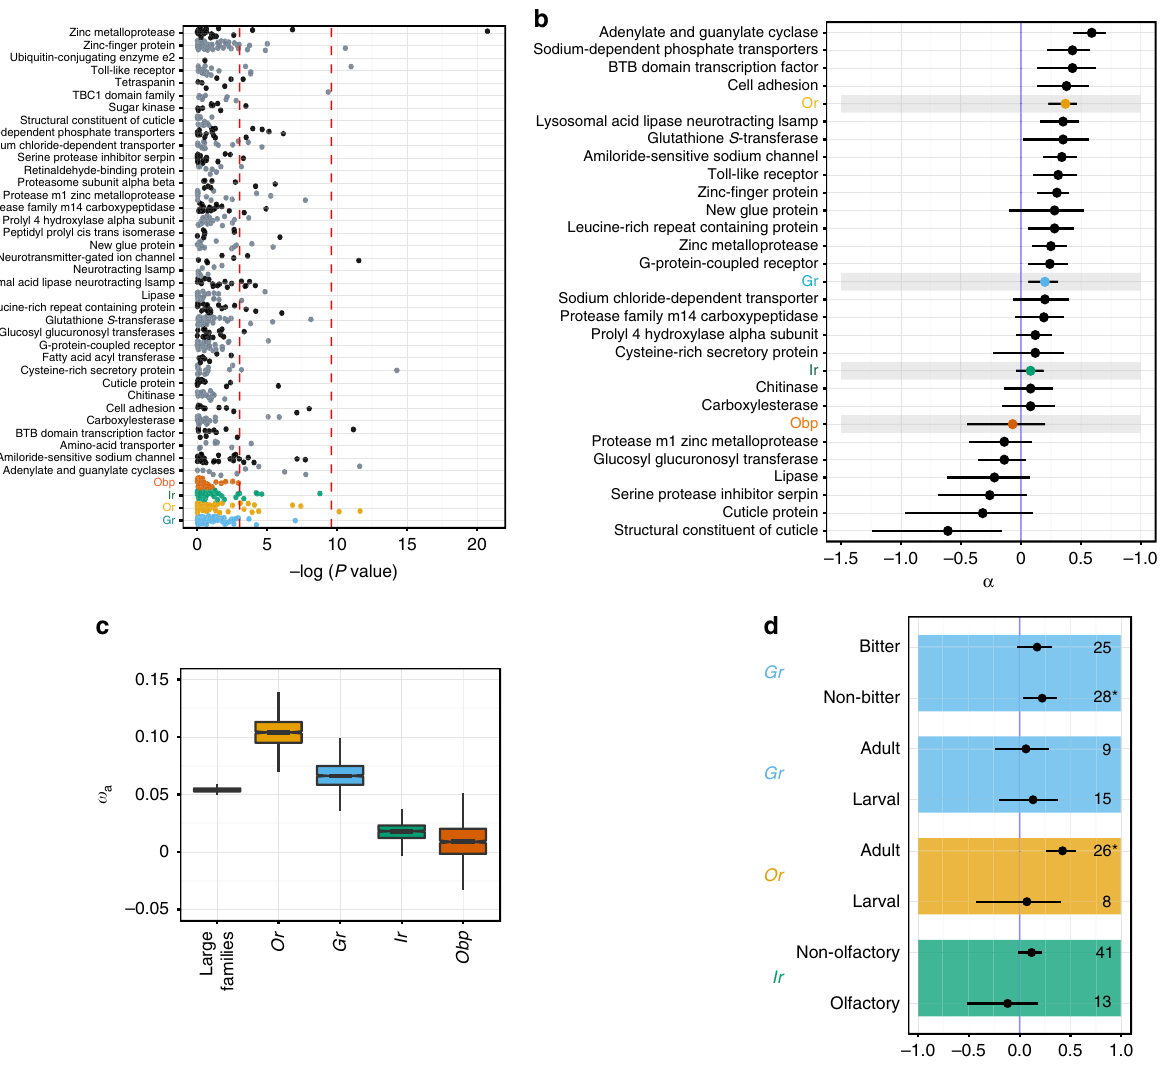
Figure 2 | Adaptive divergence analyses. ( a ) Manhattan Plot for large protein family MK test P values. Left-most red line denotes the 5% significance level; right-most red line denotes Bonferroni correction significance threshold. ( b ) Rank-ordered plot of the fraction of adaptive substitutions ( a ) inferred across the large protein families. Coloured spheres represent the maximum likelihood a estimates, with horizontal lines indicating the 2 units of log( L ) confidence intervals. The total number of families included in the analyses was reduced to 29 due to data requirements. ( c ) Box plot comparing o a ( a divided by neutral diversity) among the chemosensory genes and the pooled non-chemosensory large protein families. The boxes show the interquartile range and bars extend to the highest and lowest outliers. ( d ) Comparisons of a between functional groupings within gene families. Numbers along the right margin indicate the number of genes included in the analyses, with asterisks indicating significantly positive a estimates ( P o 0.05; log likelihood ratio test). Black spheres represent the maximum likelihood a estimates, and horizontal lines indicate the 2 units of log( L ) confidence